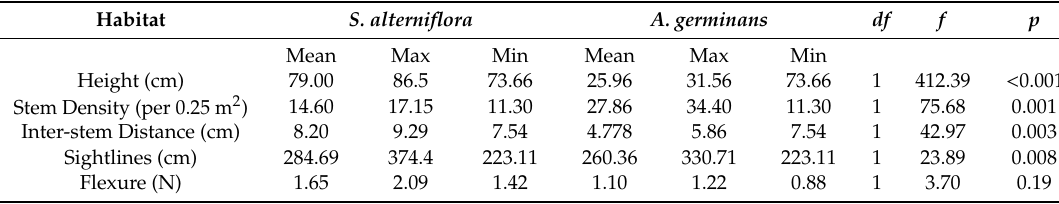
Table 1. Summary of structural attributes of S. alterniflora and A. germinans sites.